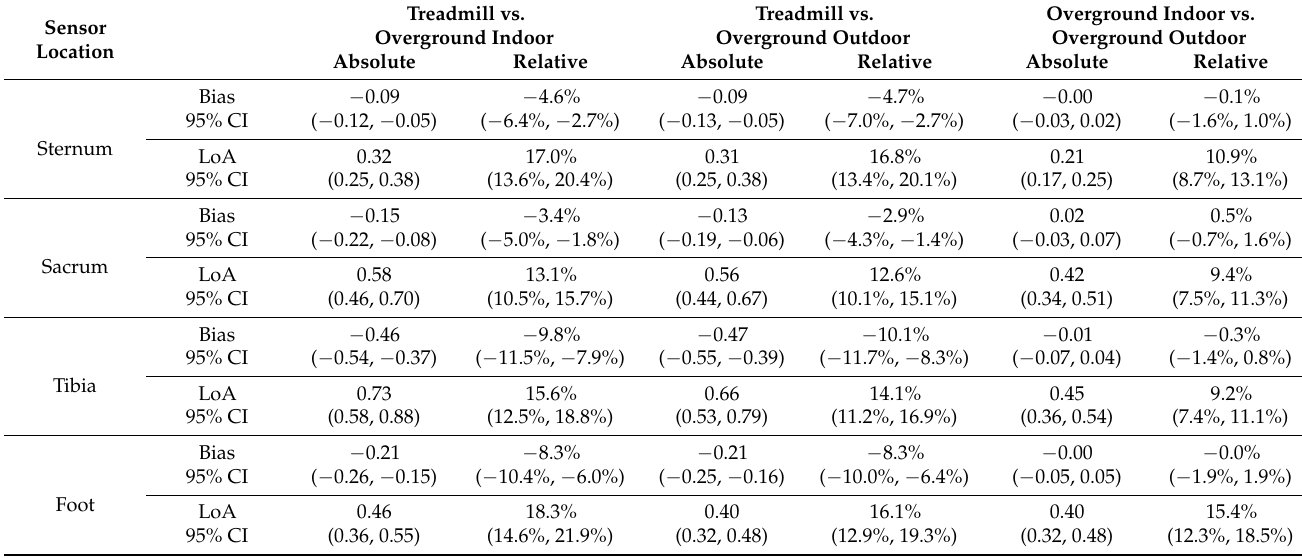
Table 3. Absolute and relative (to sensor location mean) bias and limits of agreement (LoA) with the 95% confidence intervals (CI) between the three